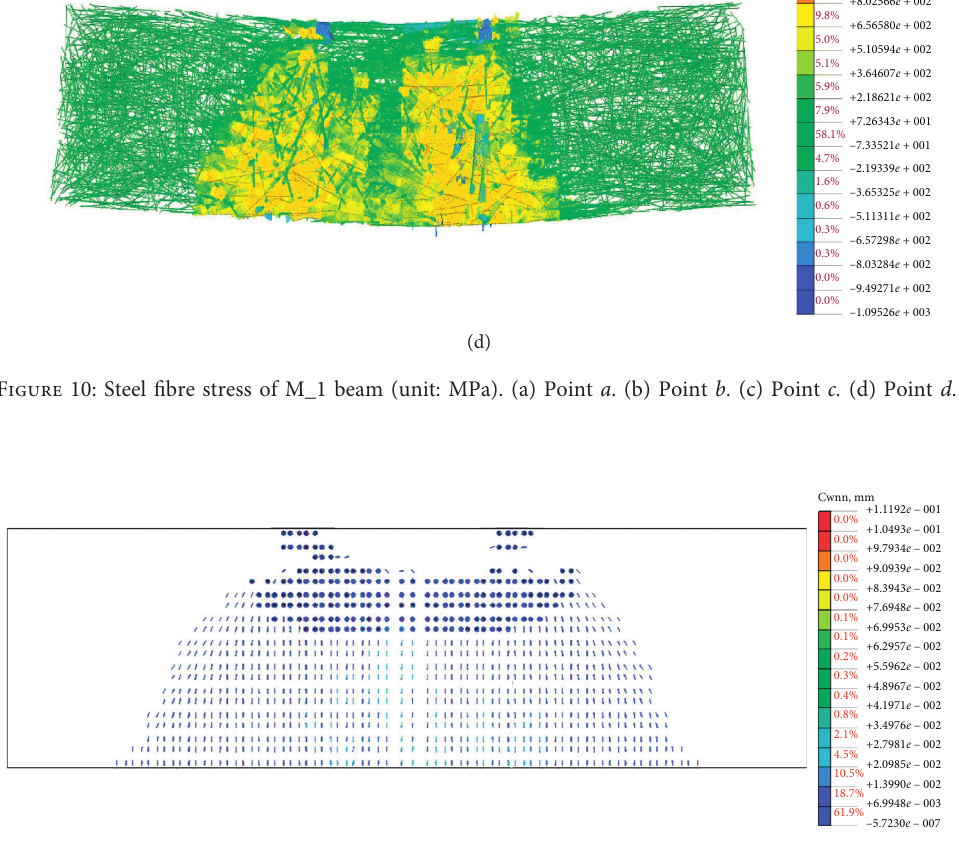
Figure 11: Crack of M_1 beam at point b (unit: mm).